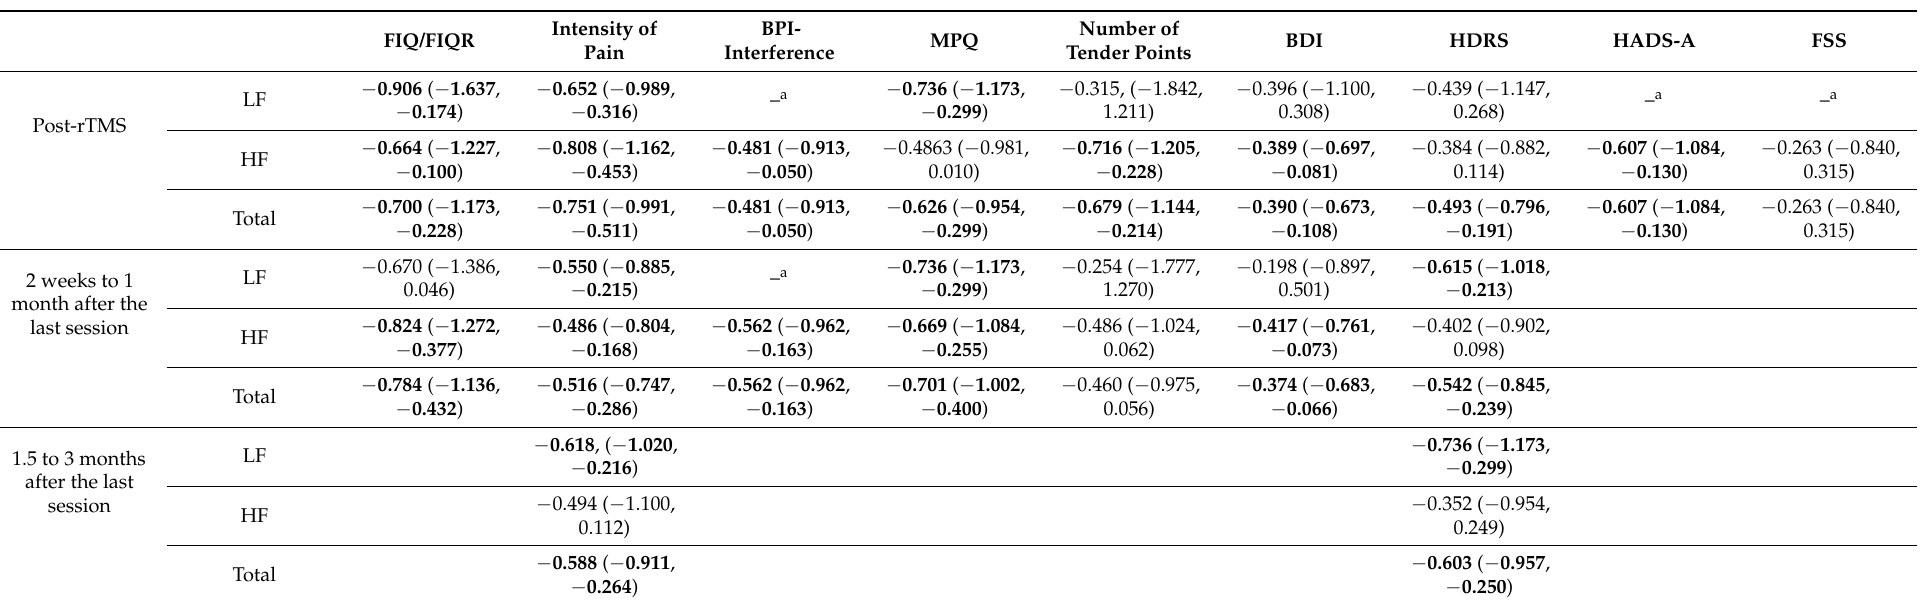
Table 5. Subgroup analyses by stimulation